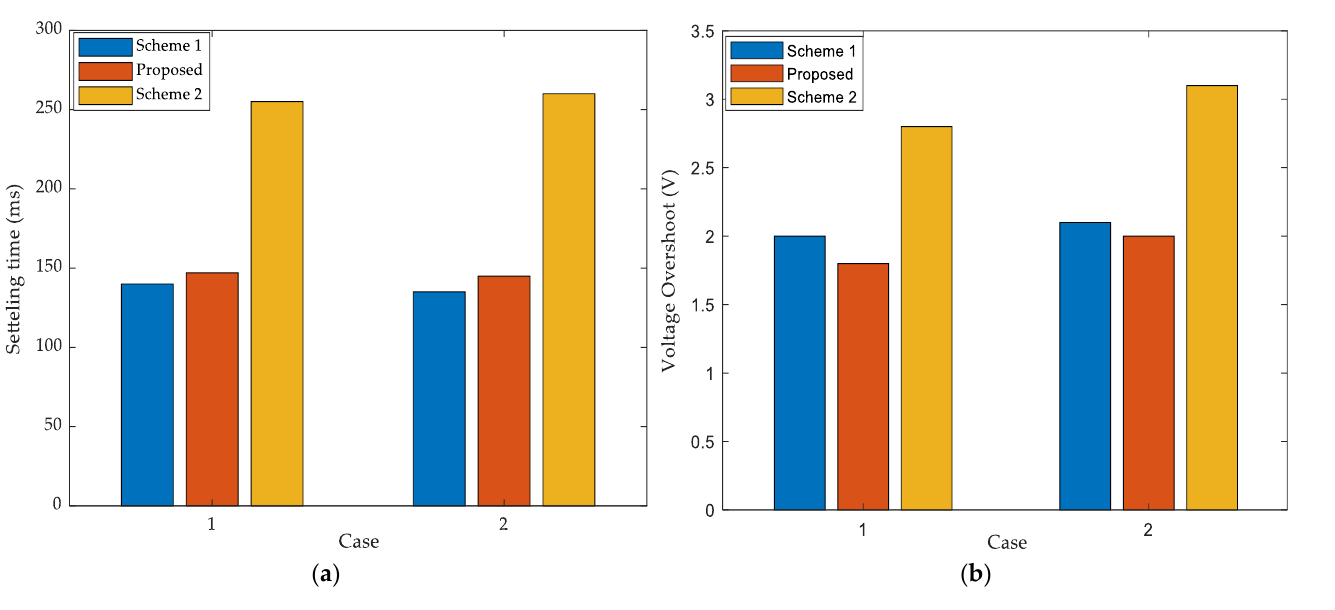
Figure 27. ( a ) Performance comparison for settling time and ( b ) performance comparison for voltage overshoot [22,26].